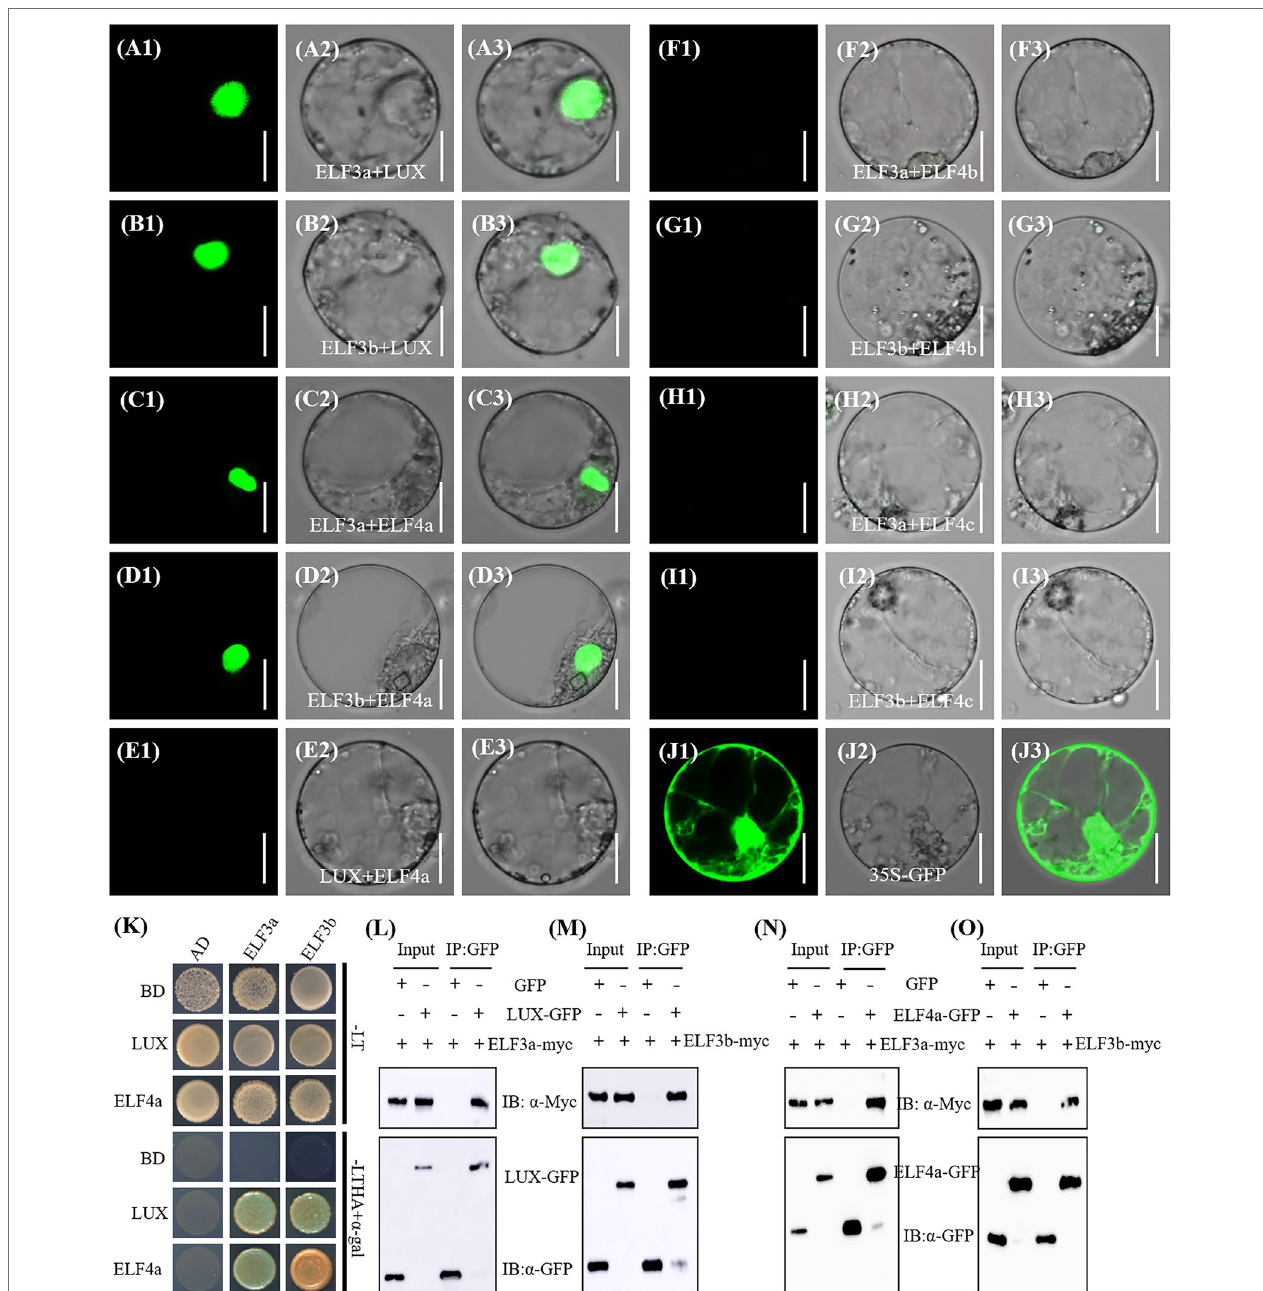
FIGURE 6 | Detection of interactions among OsLUX, OsELF3s and OsELF4s. (A-I) Bimolecular fluorescence complementation (BiFC) assay of the interaction between OsELF3a and OsLUX (A) , OsELF3b and OsLUX (B) , OsELF3a and OsELF4a (C) , OsELF3b and OsELF4a (D) , OsLUX and OsELF4a (E) , OsELF3a and OsELF4b (F) , OsELF3b and OsELF4b (G) , OsELF3a and OsELF4c (H) , and OsELF3b and OsELF4c (I) . (J) Ubi-GFP as the control. (A1-J1) GFP filter; (A2-J2) bright field; (A3-J3) merged images. Scale bars = 10 μ m. (K) yeast two-hybrid assay the interactions between LUX or ELF4a with ELF3a or ELF3b, respectively. Transformed yeast cells were grown on non-selective SD media ( − Trp-Leu/ − LT) and selective SD media ( − Trp-Leu-His-Ade/-LTHA) with X- α -Gal. (L-O) Co-IP analysis confirms that OsLUX interacts with OsELF3a (L) and OsELF3b (M) , and OsELF4a interacts with OsELF3a (N) and OsELF3b (O) ,